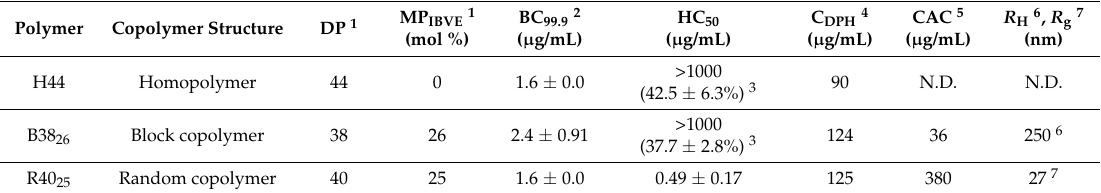
Characterization, bactericidal activity and hydrophobic dye uptake behaviors for poly(IBVE- co